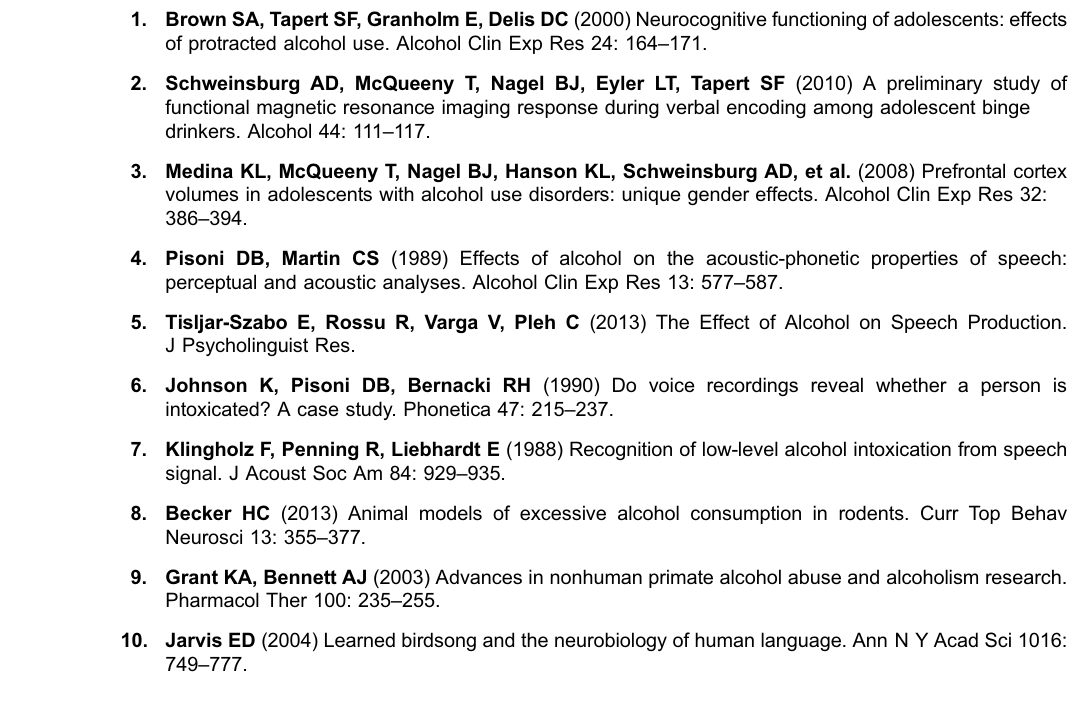
S4 Fig. Dose-relationships between BEC and syllable-level (A) amplitude and (B) duration, and (C) entropy. The vertical axes are residual values centered around syllable and individual bird means. Individual birds are represented by unique colors; the traces are spline fits ( l 5 100,000). S1 File. Combined supporting tables of alcohol effects singing parameters. Table S1 documents statistical effects of alcohol on the amount of song, Table S2 documents statistical effects of alcohol on song acoustic features and Table S3 lists the effect of alcohol on song stereotypy. S2 File. Video of alcohol effects on the acoustic features of select zebra finch syllables. Syllables include, first, the example from Fig. 9, and second, a syllable with higher spectro-temporal complexity. Vocalizations are shown serially, first while drinking juice and then while drinking 6.5% alcohol in juice, at normal and reduced